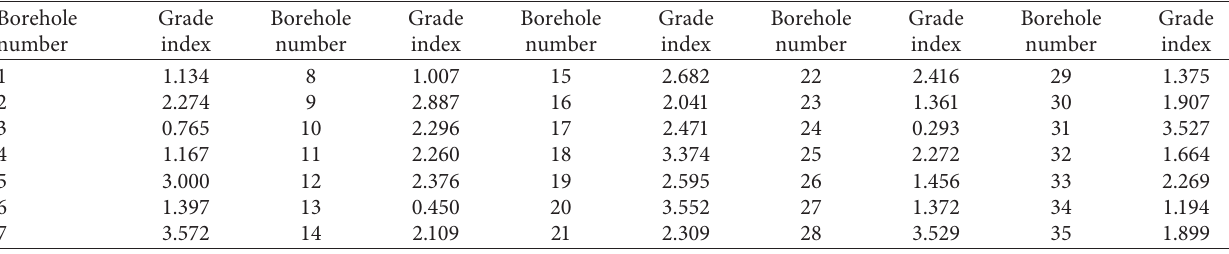
Table 7: The grade and degree